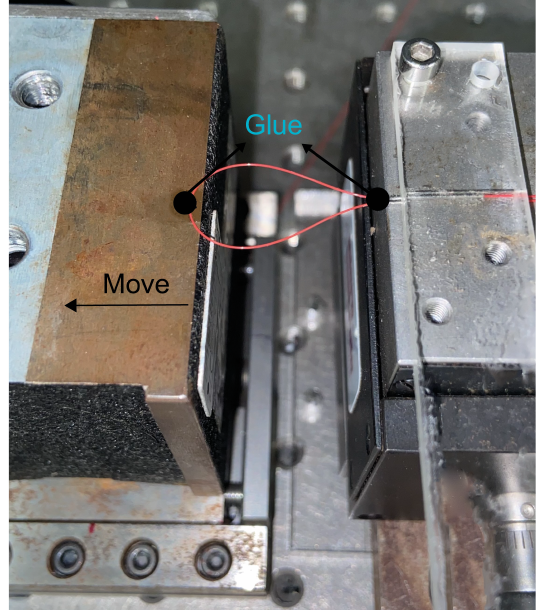
Figure 3. Picture of the proposed setup to micro-displacement